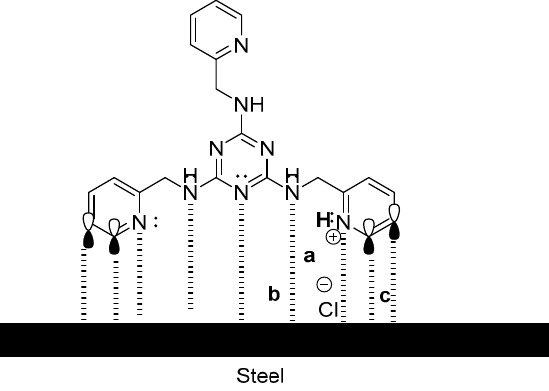
Figure 10. Proposed Schematic representation of the adsorption of the hydrazino-1,3,5-triazines on steel in 1.0 M HCl solution: ( a ) physical adsorption; ( b ) and ( c ) chemical adsorption.